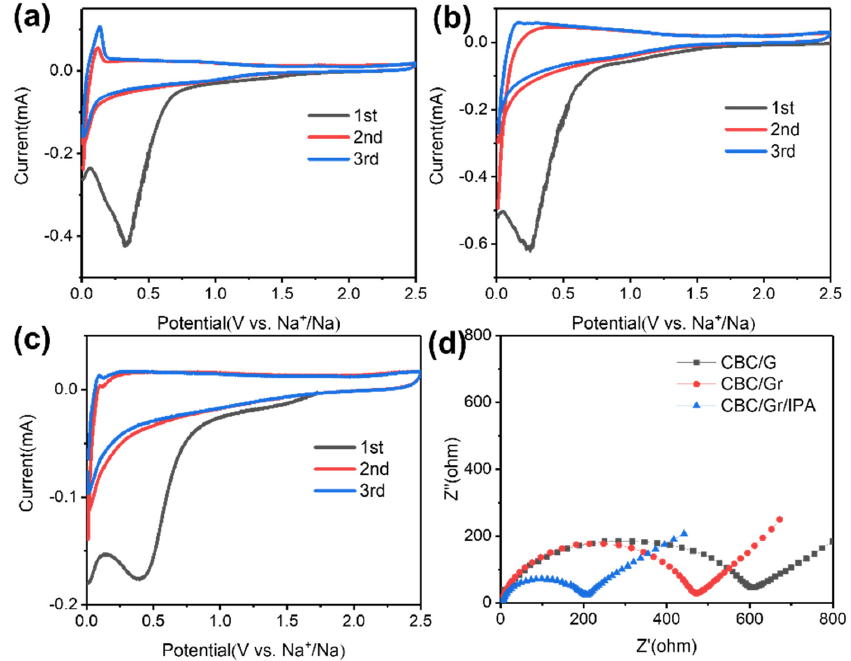
Figure 5. ( a – c ) CV curves of 1st, 2nd, and 3rd cycles at 0.1 mV s − 1 and ( d ) Nyquist plots of CBC/G, CBC/Gr, and CBC/LEGr-I.